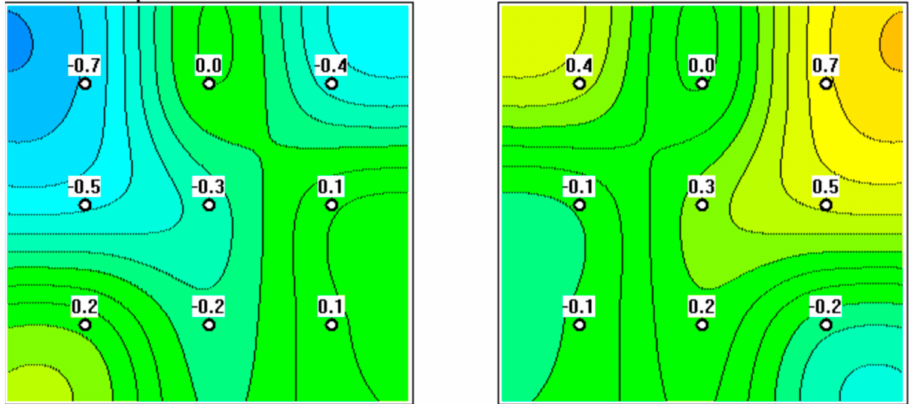
Figure 4. MWR was performed on a 59-year-old patient. Focal hyperthermia in the projection of the left ovary is evident, putting the patient in the high-risk